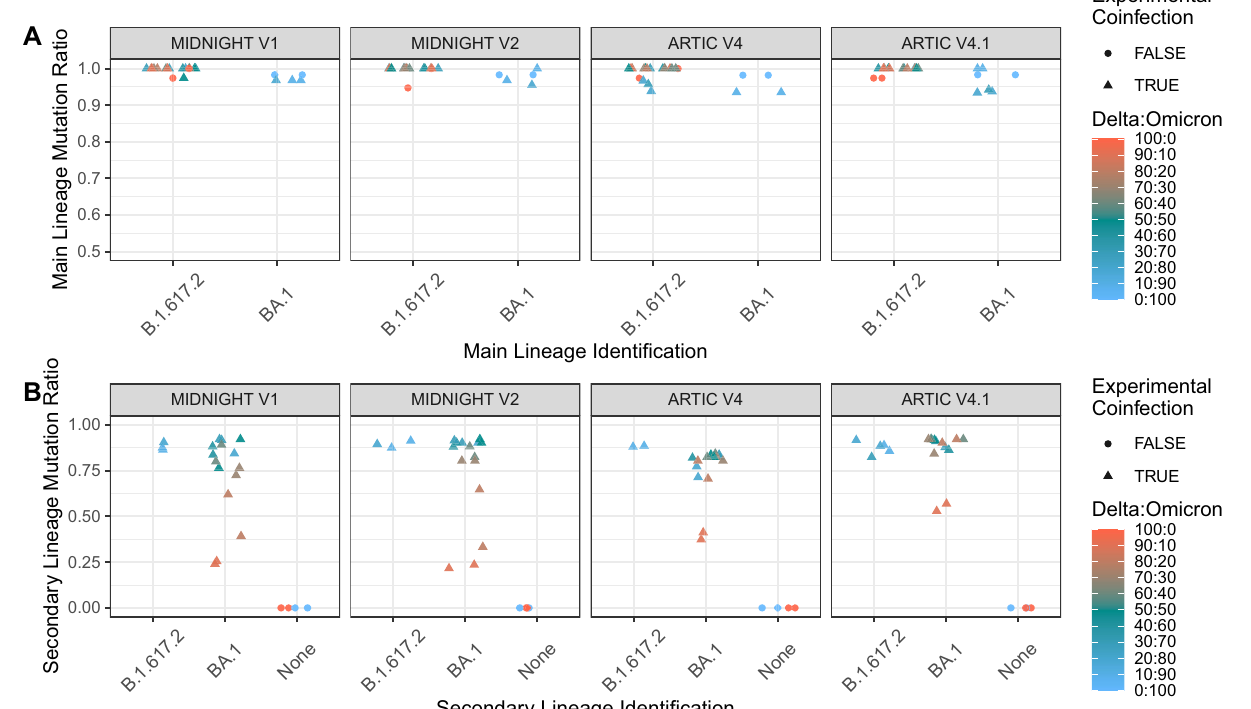
Fig. 2 | Best main and secondary lineage matches identi fi ed for each Delta: Omicron mix, based on without a priori comparison to a comprehensive lineage mutation database. A Best main lineage match ratio for each Delta: Omicron mix, considering all mutations expected for the given lineage. B Best secondary lineage match ratio for each mix, considering mutations expected for